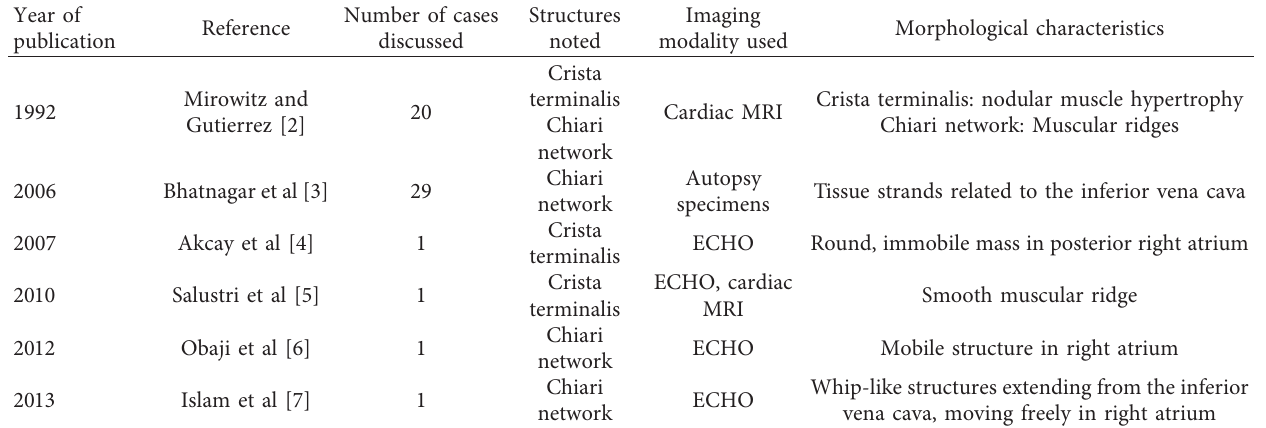
Figure 3: A diagram showing the normal structures in the primitive right Table 1: Reported normal anatomic variants in the right atrium.